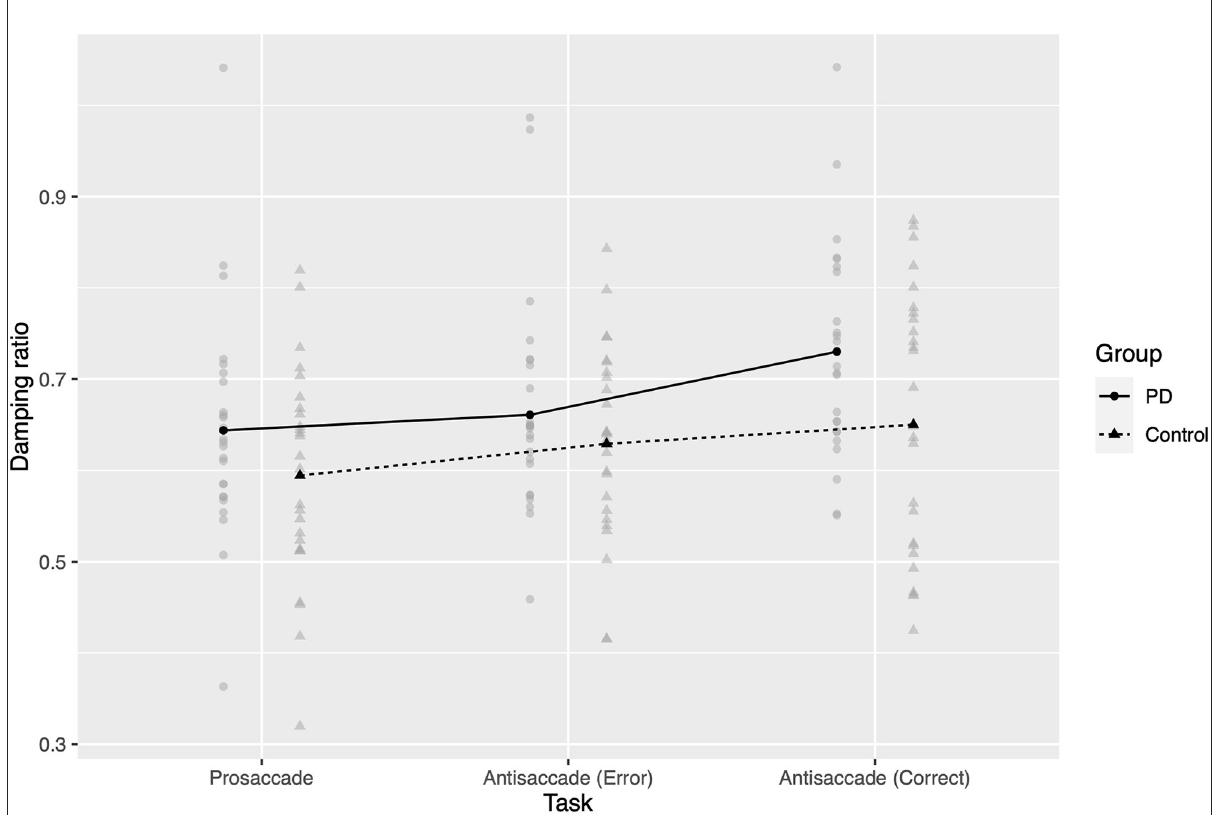
FIGURE3 Estimated damping ratios. Gray points represent mean estimated damping ratio for one participant in a given task. Black points and lines represent estimated marginal group